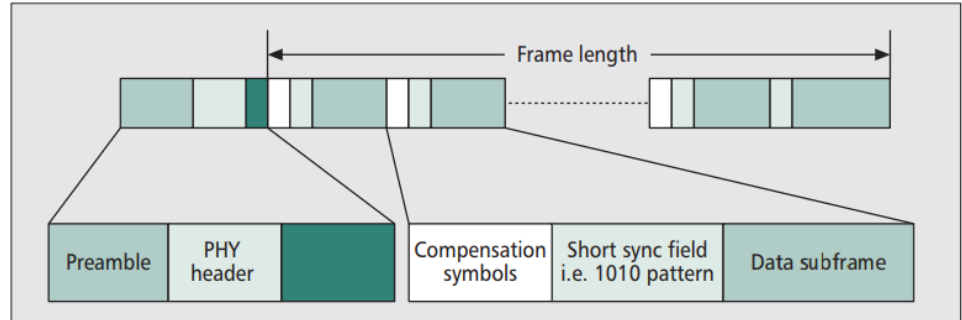
Figure 3. OOK gradation